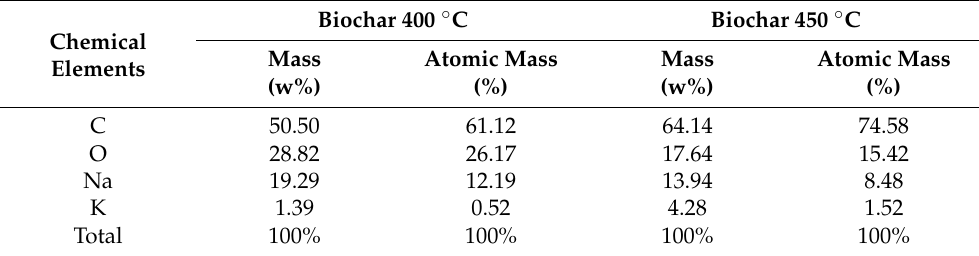
Table 4. EDX analysis of impregnated